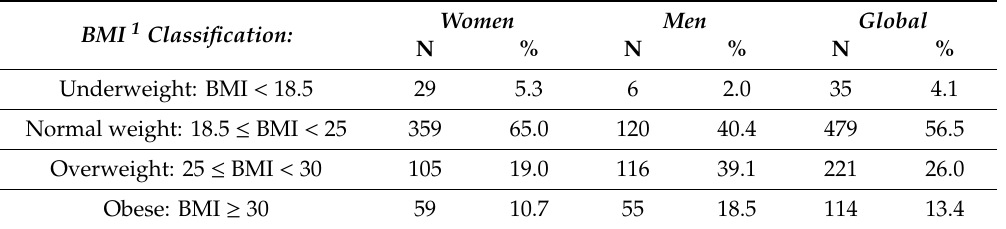
Table 3. Classification of the participants’ Body Mass Index (BMI = weight / height 2